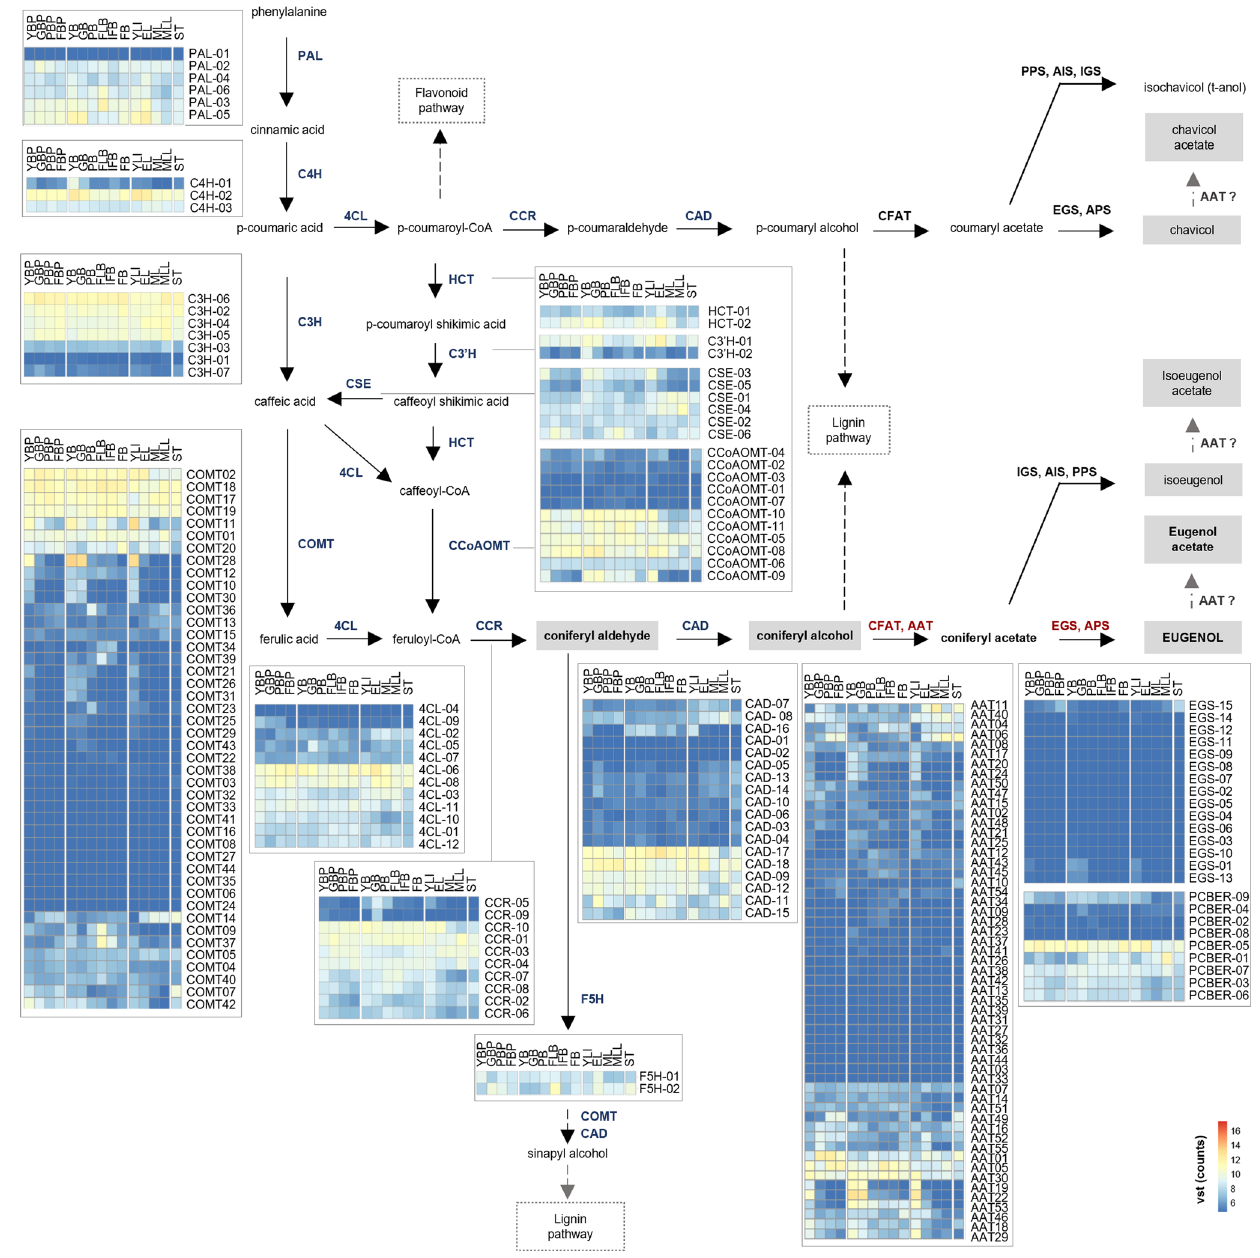
Fig. 3 Proposed biosynthetic pathways for lignin precursors and phenylpropene volatiles in Syzygium aromaticum (adapted from ref. 24 and ref. 25 ) and RNAseq evidence of expression of the identi fi ed biosynthetic genes. Gene families involved in the biosynthesis of precursors of lignin, monolignol coniferyl alcohol, coumaryl alcohol, and sinapyl alcohol are indicated in blue; gene families involved in the biosynthesis of coniferyl acetate and eugenol are indicated in red, and those involved in the biosynthesis of the phenylpropenes chavicol, isoeugenol, and t-anol are indicated in black. Compounds detected in clove leaves and buds are in gray boxes. The gray arrows indicate hypothetical reactions leading to the formation of phenylpropenes and their respective esters via the activities of alcohol acyltransferase (AAT). Heatmaps represent the relative expression pro fi les of the biosynthetic genes in peduncles of young buds (YBP), peduncles of green buds (GBP), peduncles of pink buds (PBP), peduncles of buds in the fruiting stage (FBP), young buds (YB), green buds (GB), pink buds (PB), fl owering bud (FLB), buds in the initial fruiting stage (IFB), buds in fruiting stage (FB), young leaves (YLI), expanded pale green leaves (EL), mature leaves (ML), mature leaf laminas (MLL), and stems (ST). n = 2 for fl owering bud (FLB) and peduncles of pink buds (PBP) and n = 3 for all other groups. PAL phenylalanine ammonia-lyase, C4H cinnamate 4-hydroxylase; C3H 4-coumarate 3-hydroxylase, COMT, caffeate/5-hydroxyferulate 3- O -methyltransferase, F5H, ferulate 5-hydroxylase/coniferaldehyde 5-hydroxylase, 4CL 4-hydroxycinnamate:CoA ligase, HCT 4-hydroxycinnamoyl CoA:shikimate/quinate hydroxycinnamoyltransferase, C3 ′ H 4-coumaroyl shikimate/quinate 3 ′ -hydroxylase, CSE caffeoyl shikimate esterase, CCoAOMT caffeoyl CoA 3- O -methyltransferase, CCR cinnamoyl CoA reductase, CAD cinnamyl alcohol dehydrogenase, CFAT coniferyl alcohol acyltransferase, EGS eugenol synthase, APS allyl-phenylpropene synthase, IGS isoeugenol synthase, PPS propenyl-phenylpropene synthase, AIS anol/isoeugenol synthase, AAT alcohol acyltransferase, VST variance stabilizing transformation.